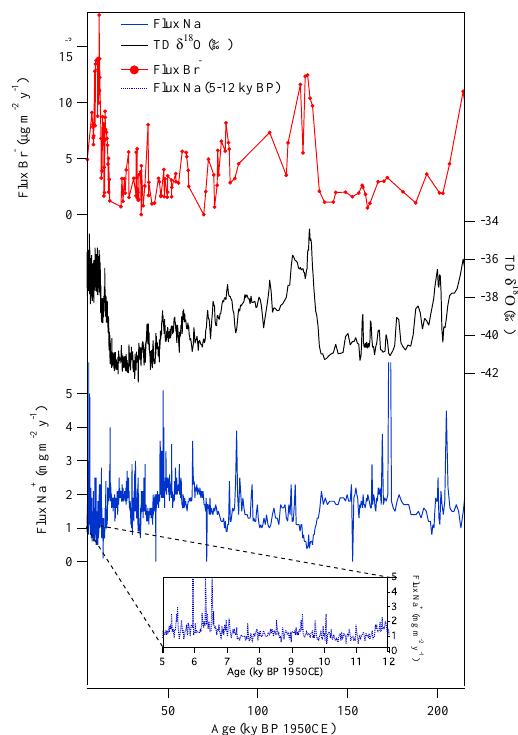
Fig. 3. Plot of Br − fluxes (red) as a function of time in the TD ice core. Br − fluxes correlate with δ 18 O (a proxy for the temperature record - black curve) and anti-correlate with Na fluxes (blue curve). The inset box represents the sodium flux between 6 and 12ky BP. Note that Sodium and δ 18 O are recorded as a high-resolution data set while bromide was measured at lower